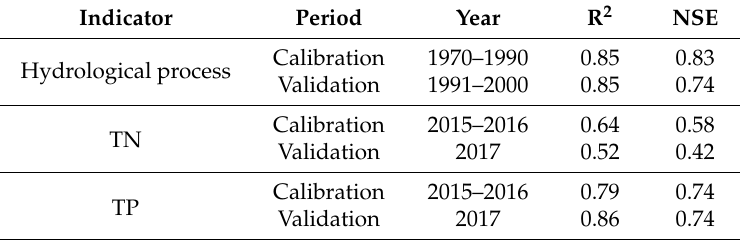
Figure 4. The calibration and validation results of TN load ( a ) and TP load ( b ) in the SWAT model. Table 4. The evaluation of calibration and validation results for hydrological processes and surface water quality. Indicator Period Year R 2 NSE Hydrological